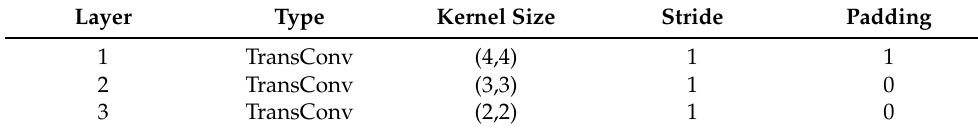
Table 2. Details of layers of Decoder